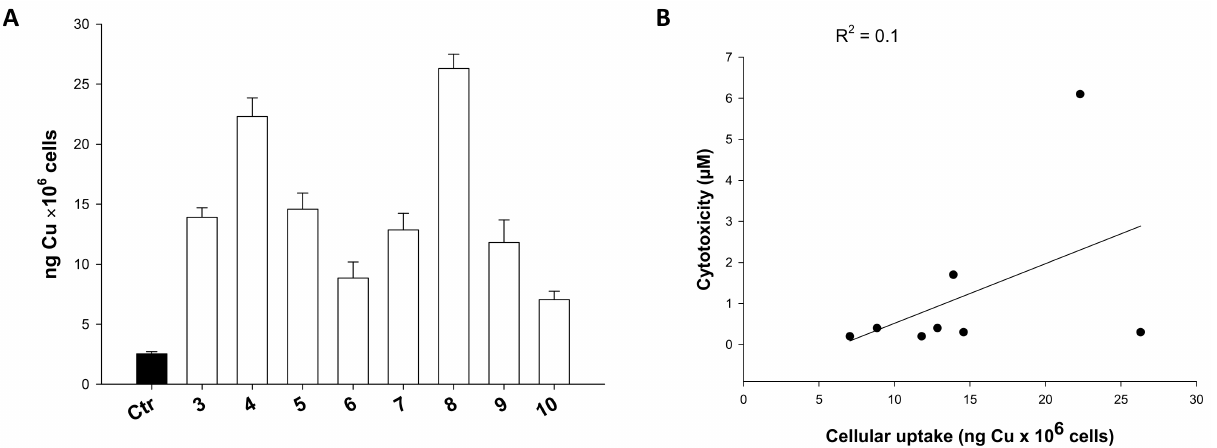
Figure 8. Cellular uptake ( A ) and correlation between cytotoxicity and cellular copper levels ( B ) in drug-treated HCT-15 colon cancer cells. Cells were incubated for 24 h with 0.75 µ M of tested complexes. The amount of cellular Cu was estimated by GF-AAS. Error bars are